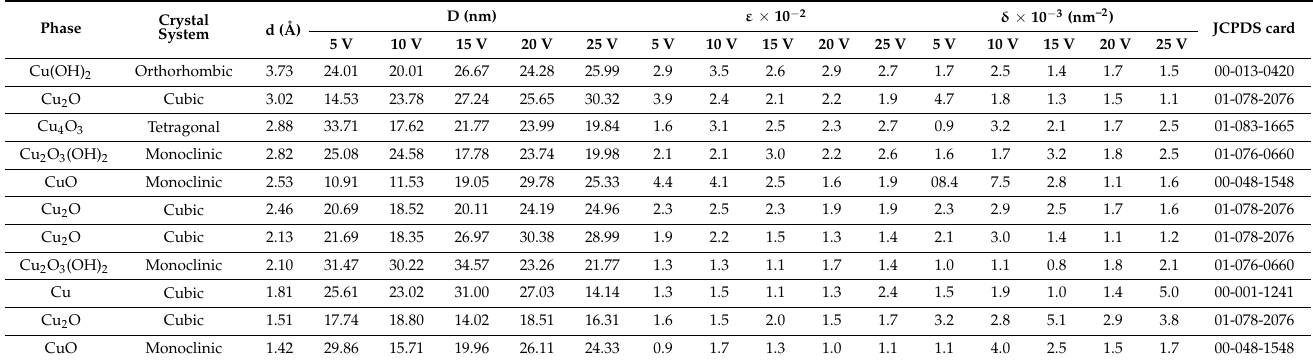
Table 1. The crystal structure, interplanar spacing (d), average crystallite size (D), microstrain ( ε ), and dislocation density ( δ ) for various formed